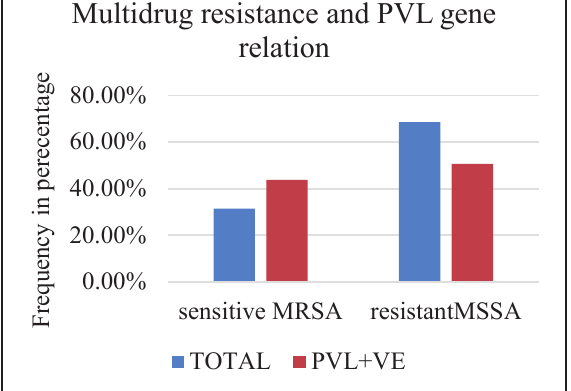
Fig-1: Relation between MDR and PVL gene